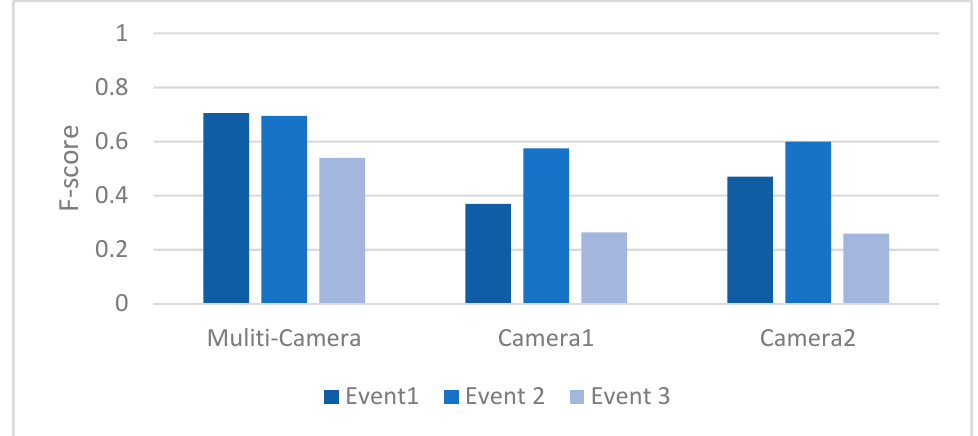
Figure 10. Event matching F-score results for the integrated architecture with multi-cameras, Cam- era1, and Camera2 for three events.